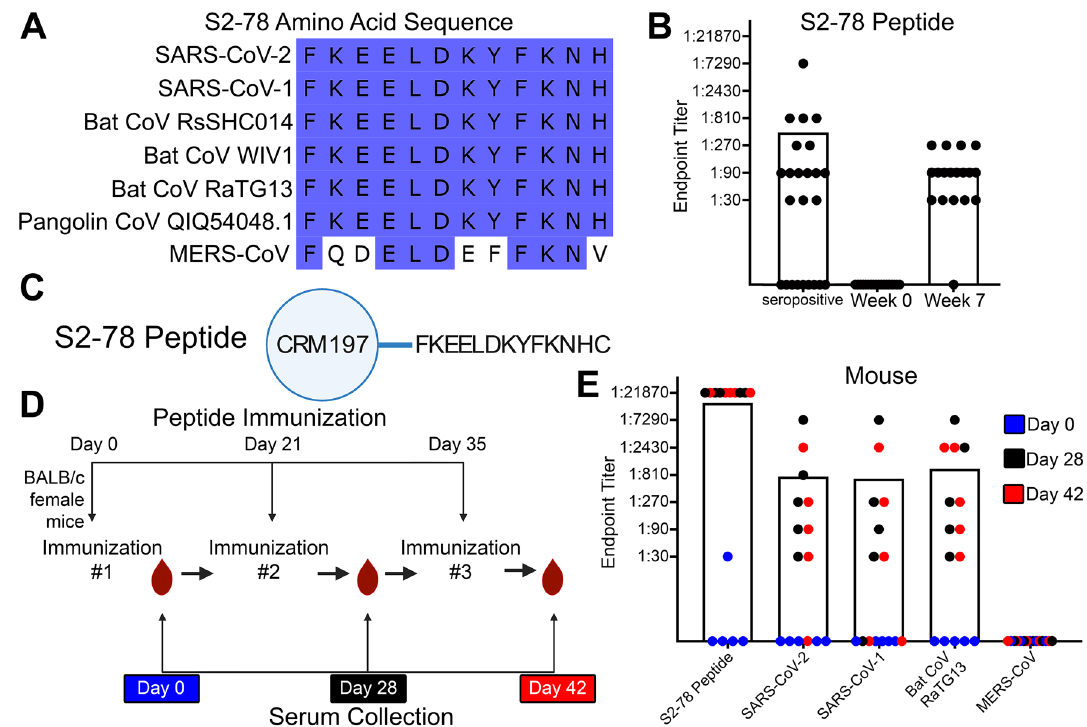
Figure 5. An immunodominant region of the S2 subunit elicited antibody responses against SARS-CoV-2 and other related viruses. ( A ) Amino acid sequence alignments of the S2-78 peptide across SARS-CoV-2, closely related SARS-CoV-1, three emergent bat coronaviruses (Bat CoV RsSHC014, Bat CoV WIV1, and Bat CoV RaTG13), an emergent pangolin coronavirus with the identifier QIQ54048.1 and MERS-CoV. Blue shading indicates amino acid conservation. ( B ) Bar graph of antibody responses (endpoint titers) obtained by ELISA at different plasma dilutions to S2-78 peptide in distinct vaccinated human seronegative week 0 and week 7 plasma (n = 16) and human seropositive serum (n = 24). ( C ) Schematic representation of the S2-78 peptide with the addition of the conjugated diphtheria toxin carrier protein CRM197 for immunization studies. ( D ) Timeline of the mouse experiments. ( E ) Bar graph of antibody responses (endpoint titers) obtained by ELISA at different serum dilutions of mouse serum against the S2-78 peptide, SARS-CoV-2, SARS-C0V-1, Bat CoV RaTG13 and MERS-CoV (n = 5 mice per each time point). Endpoint titers are designated by the most dilute serum concentration detected above the minimum threshold of the background OD450 multiplied by 3. Dots are representative of individual samples. Bars are representative of the mean of all